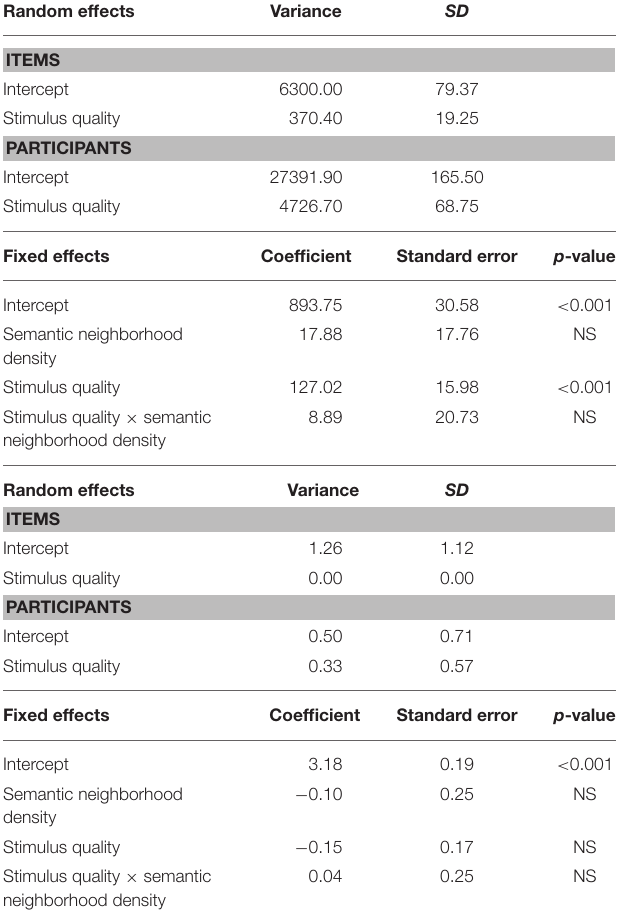
TABLE 7 | LME (top panel: RT) and GLM (bottom panel: Accuracy) model estimates for fixed and random effects for the joint effects of stimulus quality with semantic neighborhood